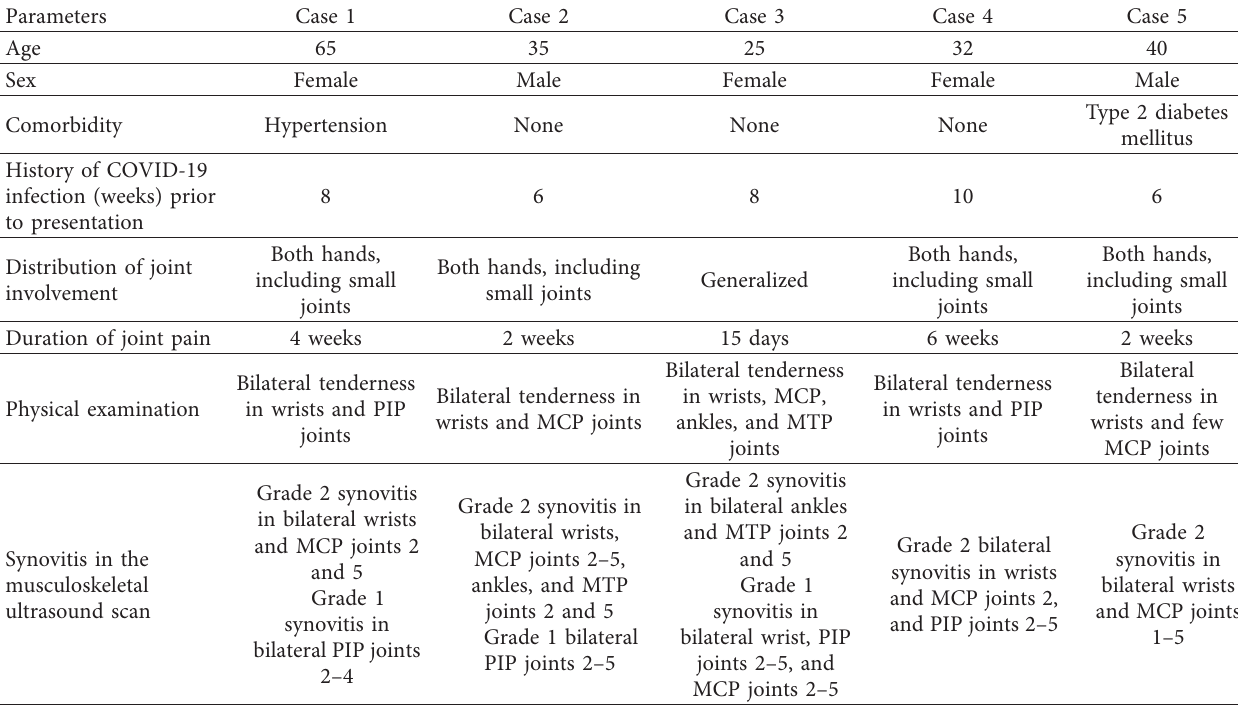
Table 1: Patient characteristics and findings.